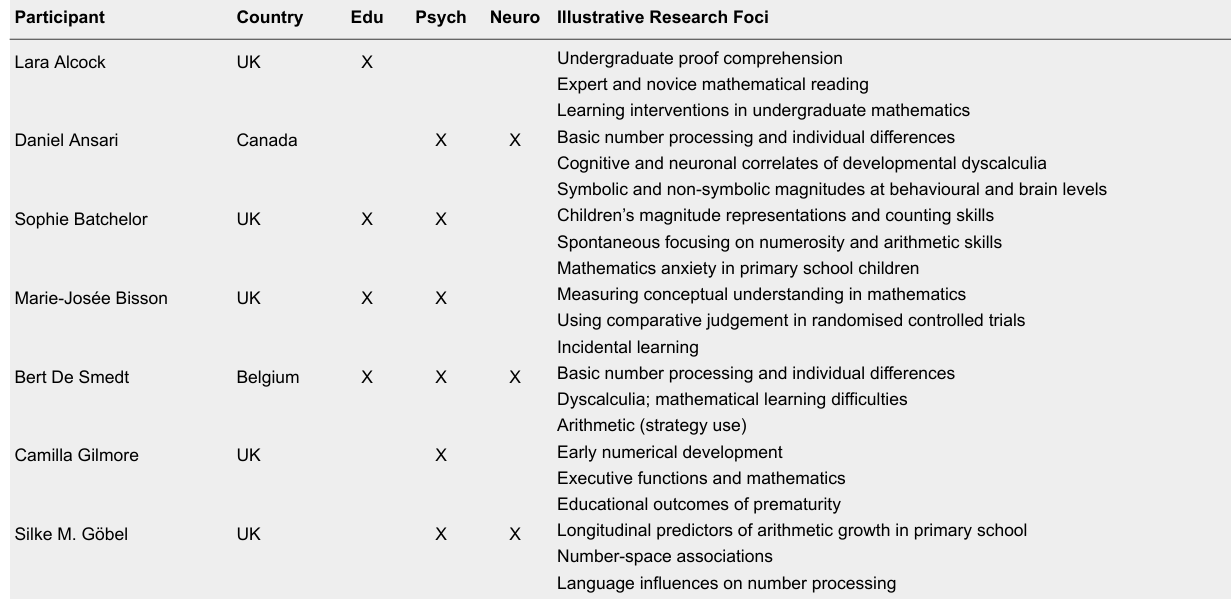
Participants’ Main Research Areas and Specific Illustrative Research Foci